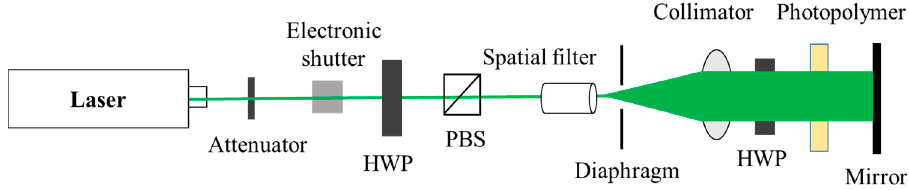
Figure 4. Vertical reflection type holographic recording optical setup.